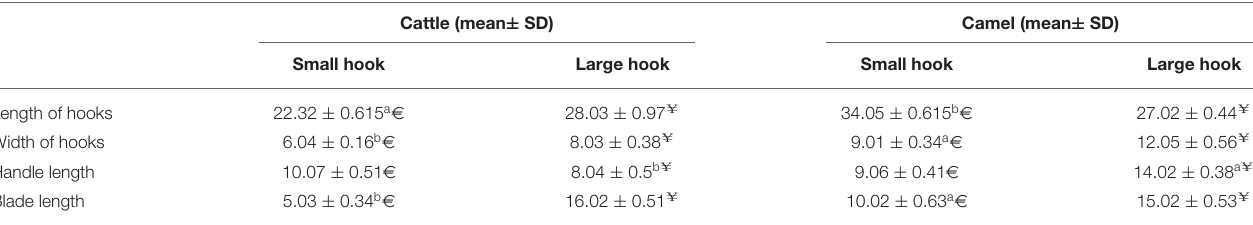
TABLE 4 | The morphometric measurements ( µ m) of total length, width, handle, and blade of large and small hooks hydatid cysts retrieved from lungs of cattle and camel [Values are means ± error of the mean (SEM)]. Cattle (mean ±